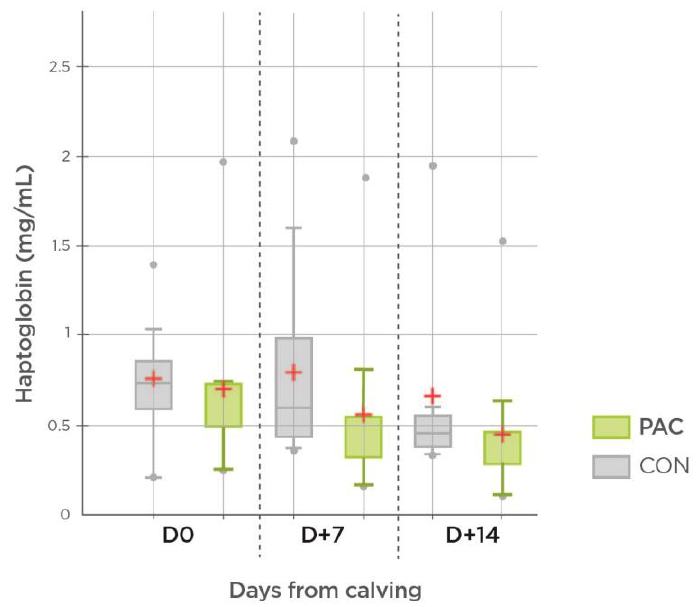
Figure 1. Effect of pant bioactive compounds on serum haptoglobin levels ( n = 23).